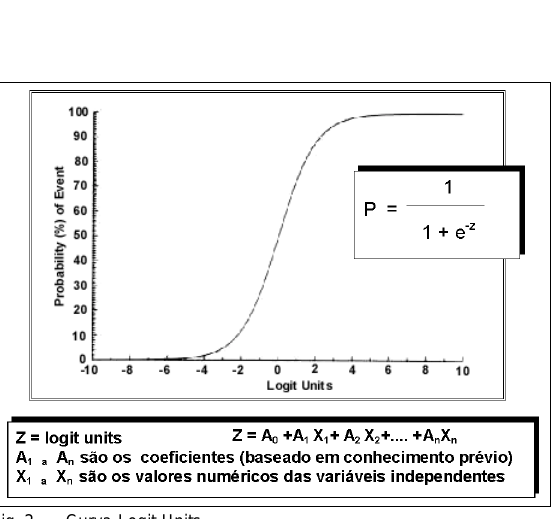
Fig. 2 - Curva Logit Units. (Fonte: Kirklin J W & Barrat-Boyes B G. Cardiac surgery. 2.ed. New York: Churchill Livingstone, 1993. v.1).